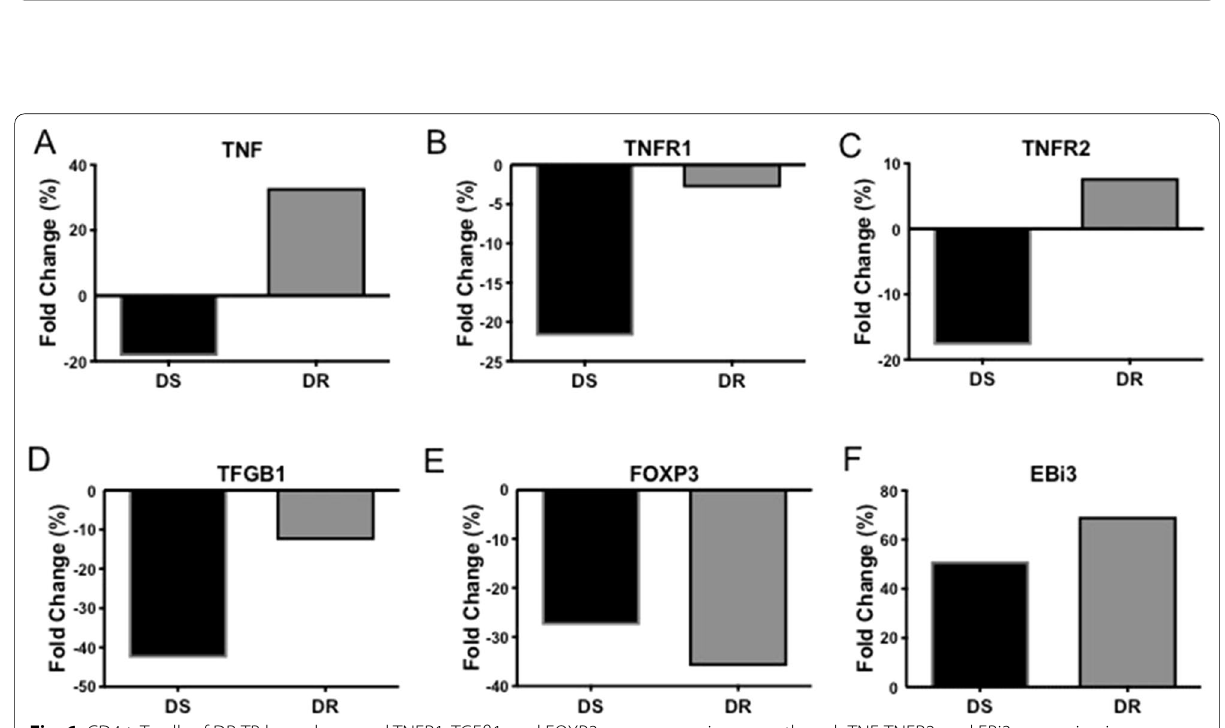
Fig. 6 CD4 T cells of DR‑TB have decreased TNFR1, TGFβ1, and FOXP3 gene expression, even though TNF, TNFR2, and EBi3 expression is + up‑regulated at the transcriptional level. We calculated the fold change percentage of expression of TNF ( A ), TNFR1 ( B ), TNFR2 ( C ), TGFβ1 ( D ), FOXP3 ( E ), and EBi3 ( F ). The percentage of fold change was calculated by obtaining the difference between six months and before of anti‑TB therapy per each group. DS‑TB n 3, DR‑TB n 3. Data are shown in bar graphs with median = =